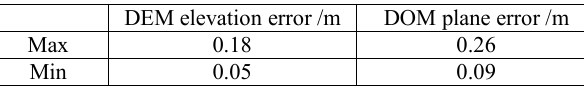
Table 2. Actual accuracy of the products